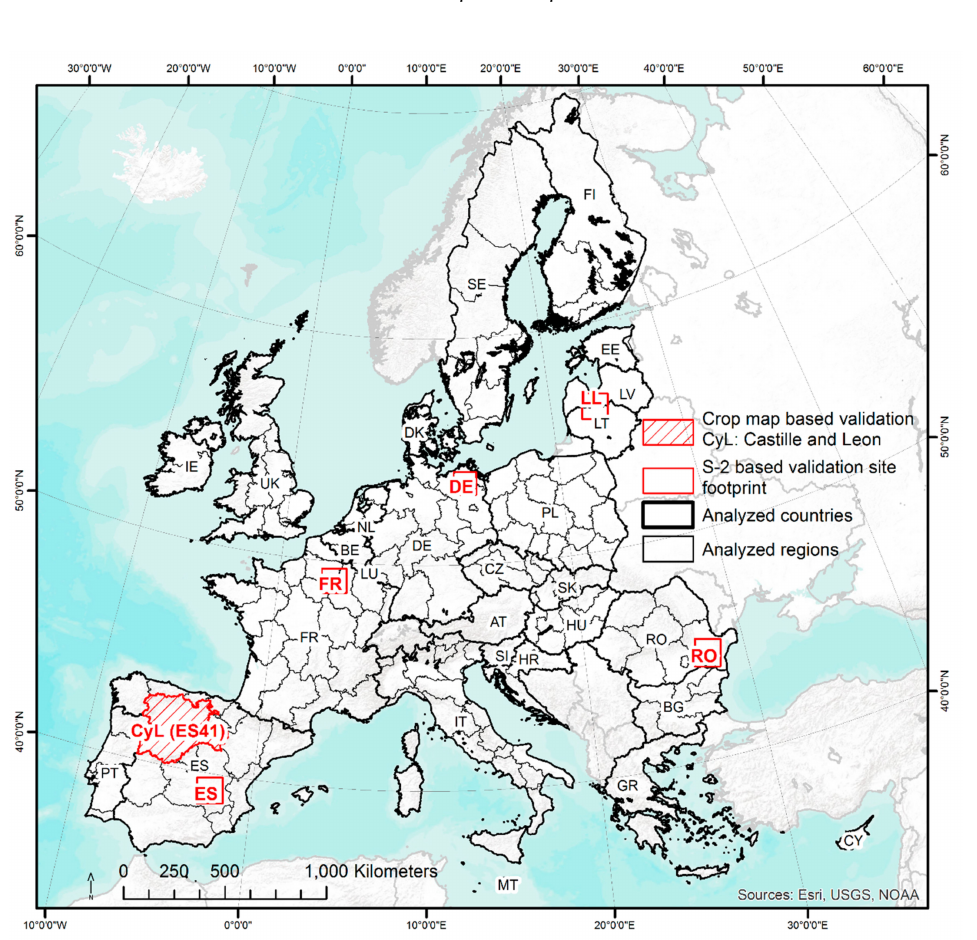
Figure 2. Study area and the analyzed NUTS regions. Validation sites in red: five Sentinel-2-based sites (S-2 footprints) and the region Castile and Leon (CyL, NUTS-region ES41) with a crop map-based validation. Analyzed countries and regions for pure pixel extraction outlined with their black